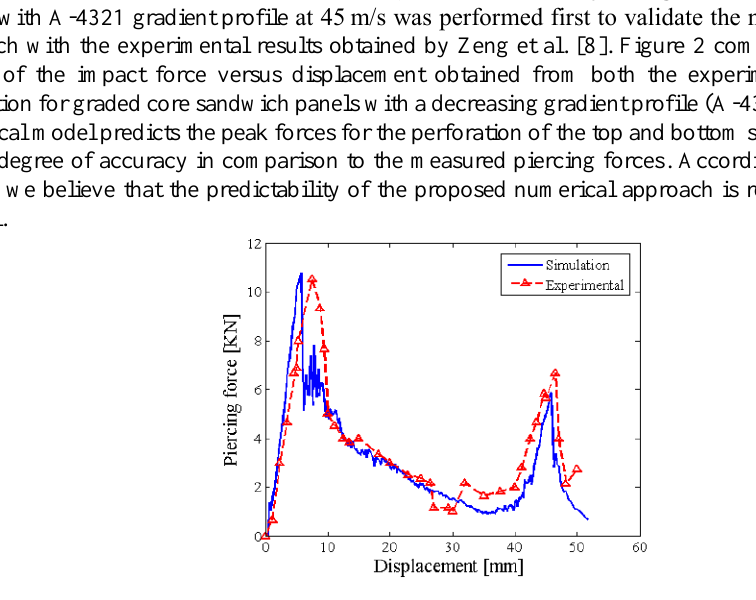
Fig. 2. Plots of piercing force versus displacement of graded core sandwich panels. Comparison between the simulation and experimental results